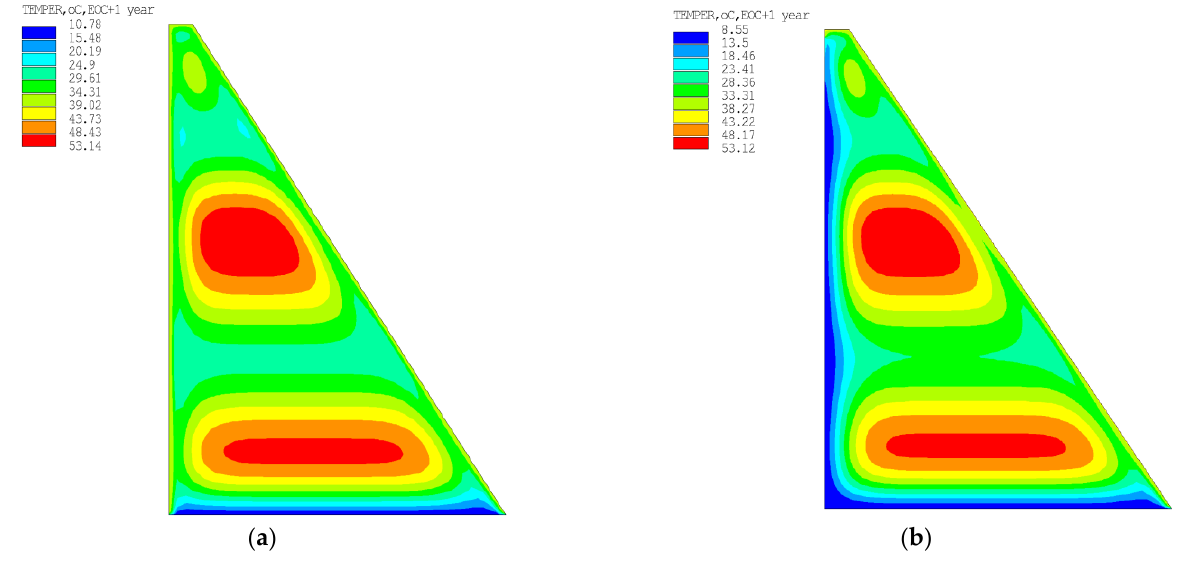
Figure 13. Results of calculating the maximum temperature in the concrete mass in the least favorable calculation case: ( a ) Calculation excluding the effect of the reservoir; ( b ) Calculations considering the effect of the reservoir.